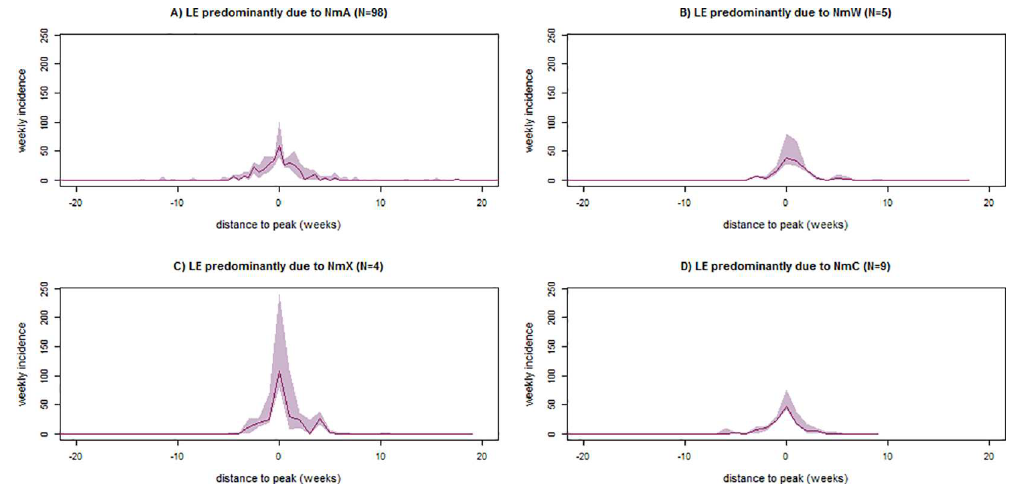
Fig 3. Epidemic curves (weekly incidence rates per 100,000) of suspected meningitis cases in health areas with localized epidemics (LE), by epidemic serogroups, in Tahoua, Tillabery and Dosso regions, Niger, 2002–2012 and 2014–2015. The localizedepidemics were defined with the threshold of 20 cases per 100,000 inhabitantsduring at least two consecutive weeks (LE20). The solid line represents the median, and the shaded area represents the 25 th and 75 th percentilesof the weekly incidences.Epidemic agents were defined accordingto the majority of pathogens identifiedby systematic polymerase chain reaction testing on cerebrospinal fluid.